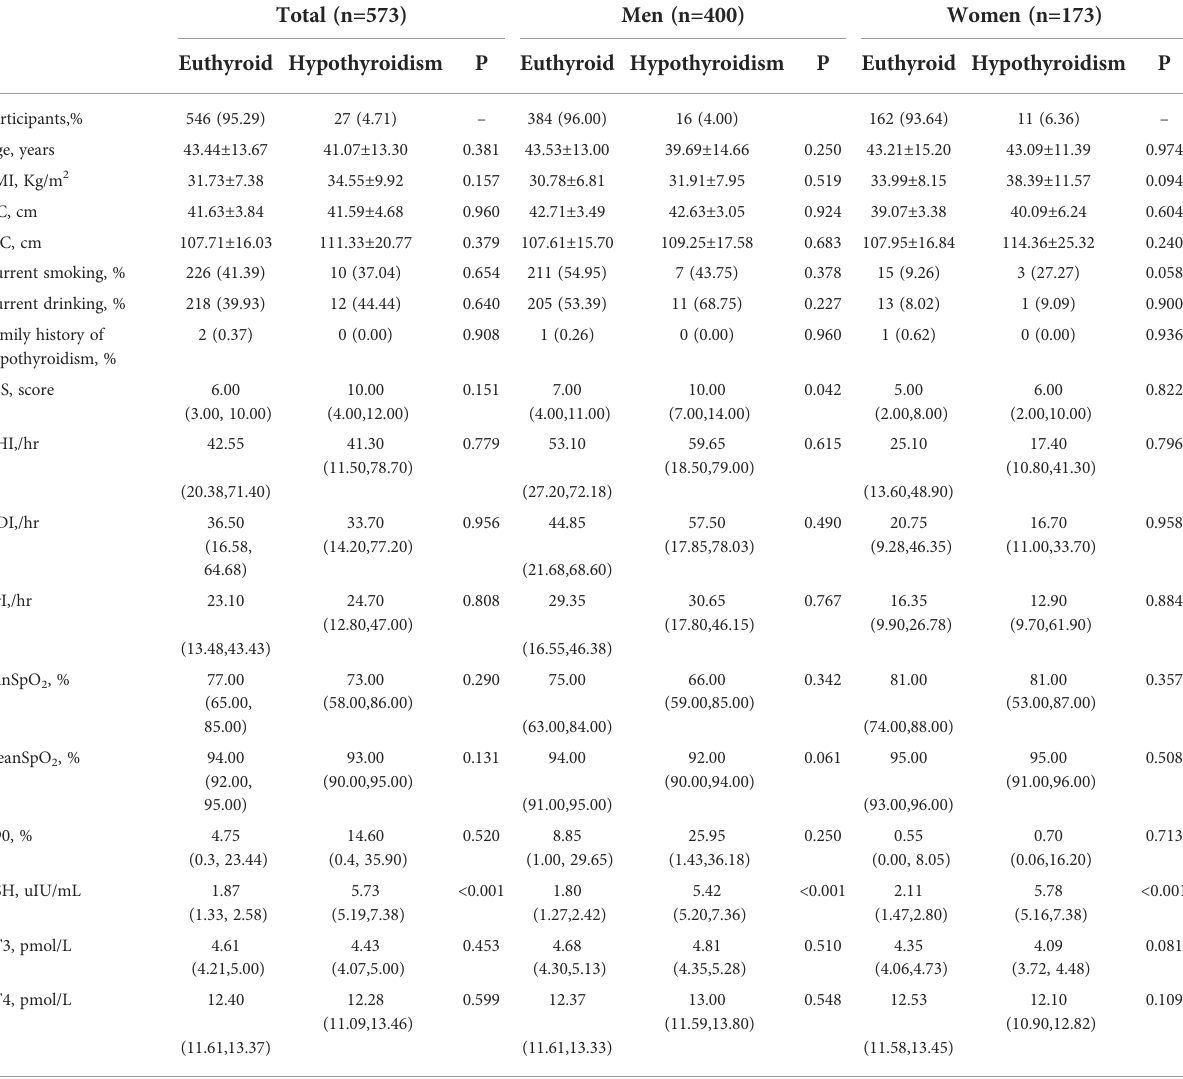
TABLE 2 With-gender comparison between OSA patients with euthyroid and hypothyroidism. Total (n=573) Men